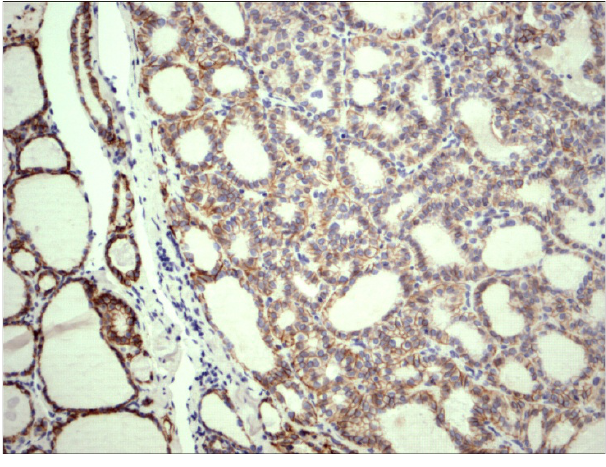
Thyrotoxicosis E-Cadherin Figure 28